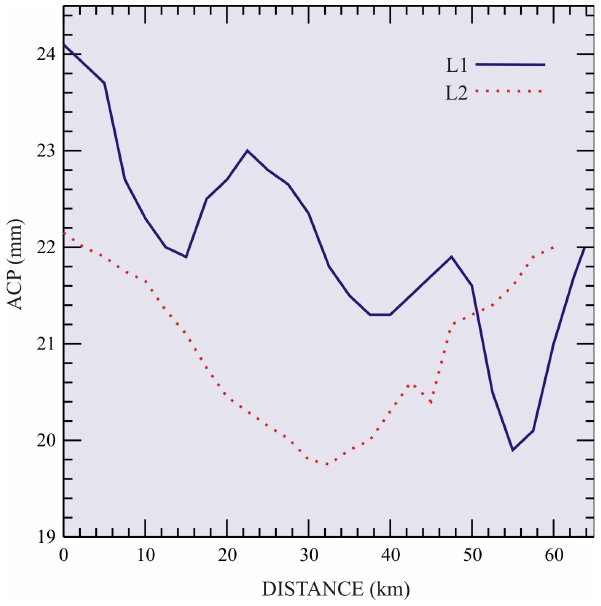
Fig. 3. Mean convective precipitation (ACP, in mm) along the L1 and L2